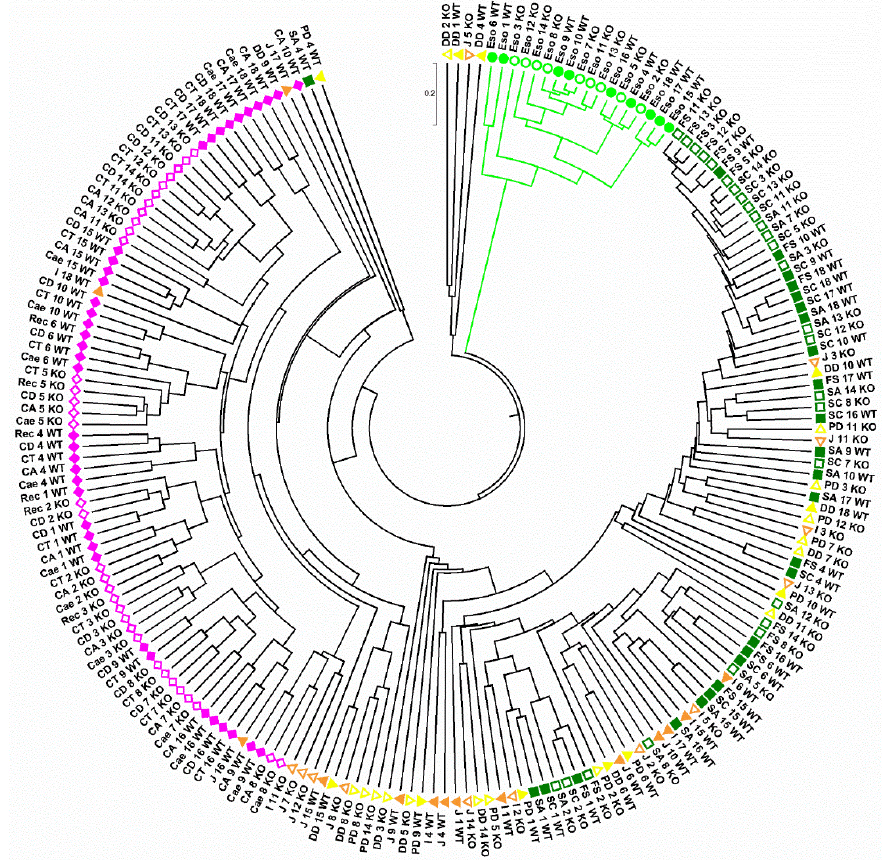
Figure 4. Group-average agglomerative hierarchical clustering of 197 samples, based on the global bacterial profiles at phylotype level and Bray-Curtis similarities. Each sample is termed by its anatomical region (for details see the legend of Figure 2), the number of the animal (from 1 to 18), and the mouse strain (wild-type or Tff3 KO ).